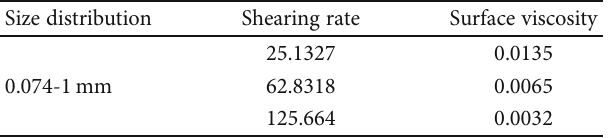
Figure 4: Schematic and physical diagram of the experimental system. (a) Schematic diagram and module physical diagram of the system; (b) physical penetrometer; (c) MTS816 system. Note : 1: base; 2: base inlet; 3: seepage plate; 4: pressure-bearing ring; 5: layered bulkheads; 6: main cylinder; 7: piston; 8: water and sand collection tray; 9: sand area; 10: broken rock mass; 11: water and sand outlet. Table 1: The relationship between shear rate and surface viscosity.